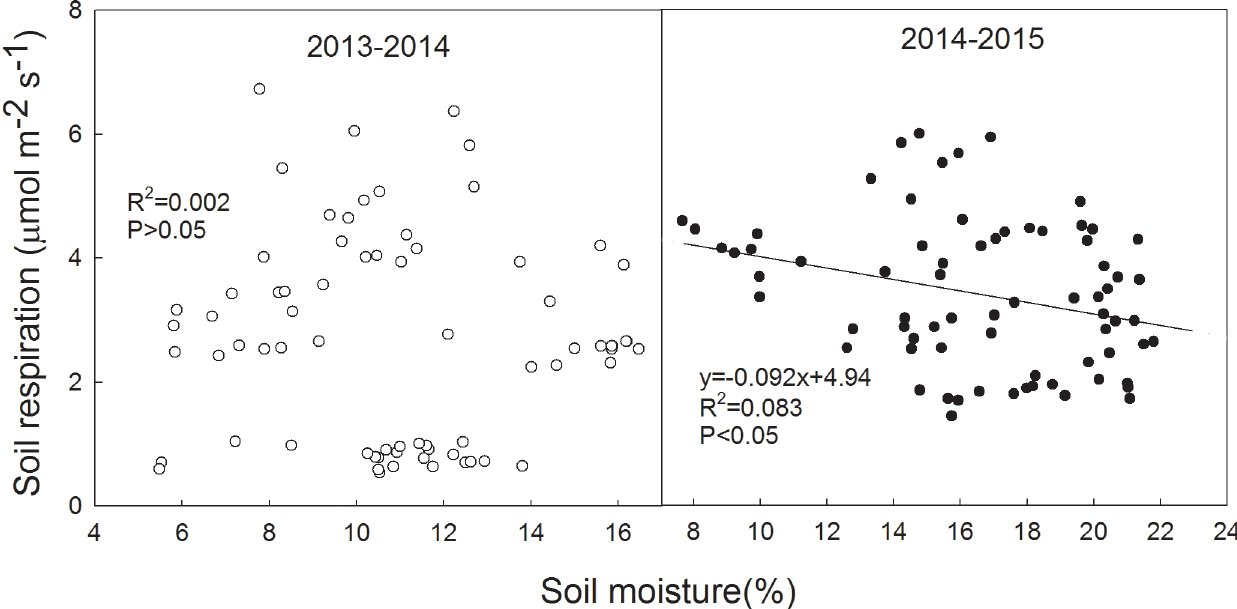
Fig 2. Relationship between soil respiration and soil moisture at 10 cm depth under all treatments during 2013 – 2014 and 2014 – 2015 winter wheat growing